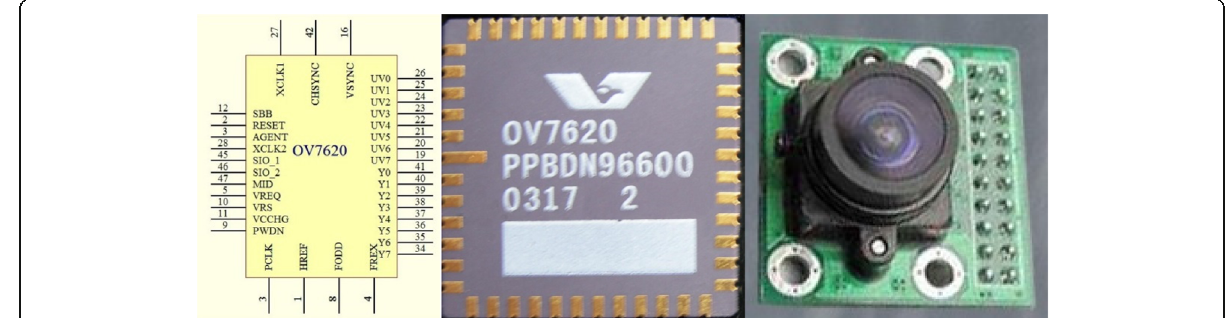
Fig. 21 Schematic diagram and physical diagram of OV7620